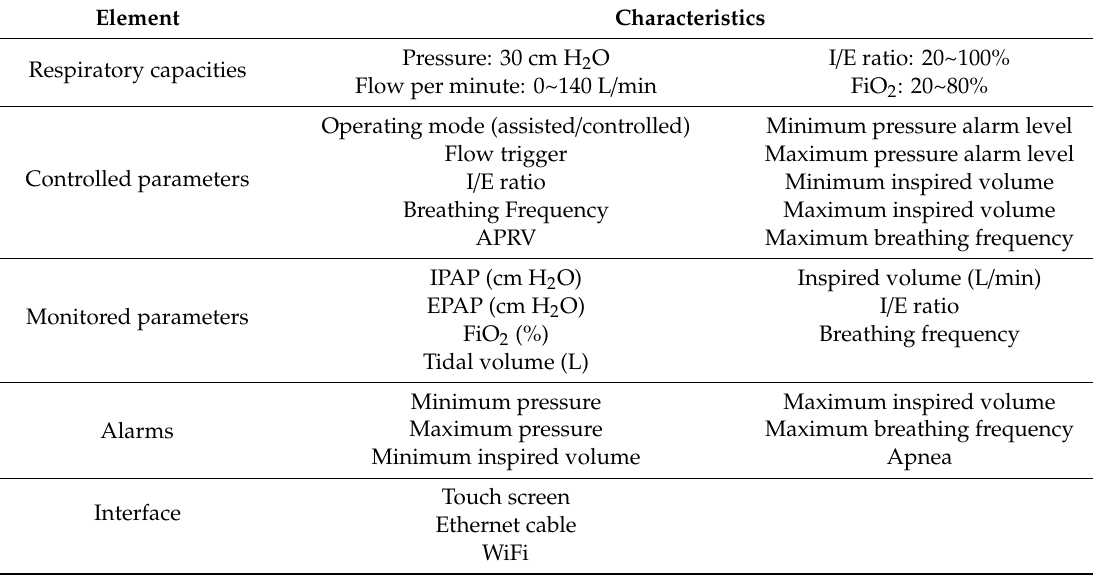
Table 2. ResUHUrge